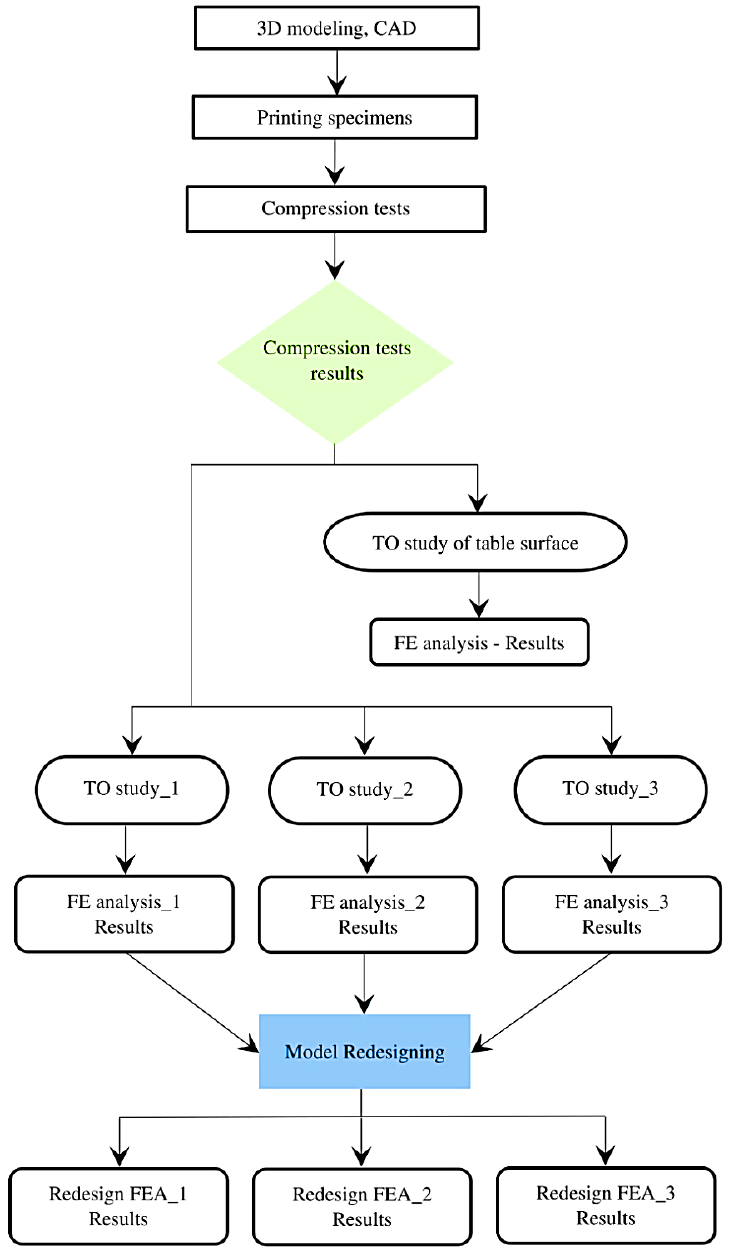
Figure 2. Research methodology